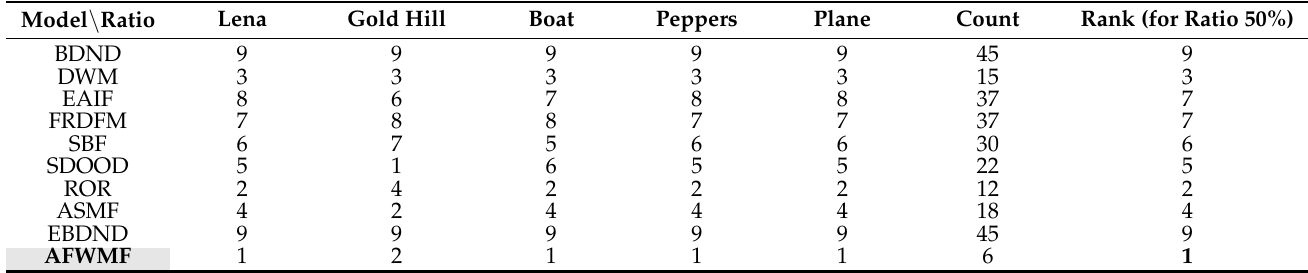
Table 8. The ranking of the 10 filter models according to the three experts’ average evaluations at 50% noise density for the five experimental images.